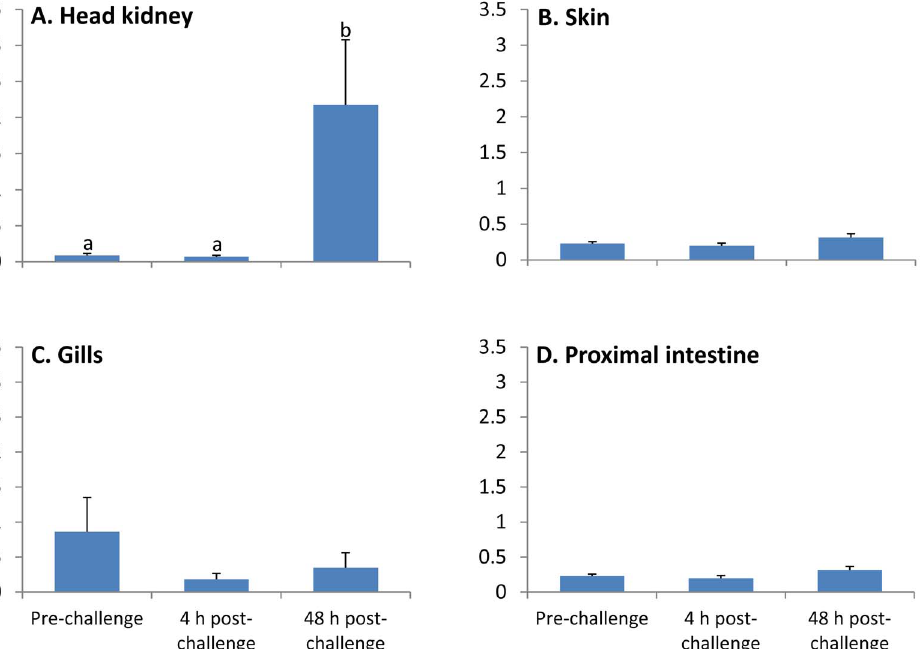
Figure 8. Relative expression of defb in immune-related tissues of Atlantic cod upon challenge with pathogenic bacteria ( Vibrio anguillarum , strain H610). Each bar represents the mean (n=6) with error bars indicating the SEM. Different letters above the bar indicate statistically significant expression differences between the challenged group of a particular treatment. Data are normalised against expression of ubi and eef1a for proximal intestine or rps9 and eef1a for head kidney, skin and gill.